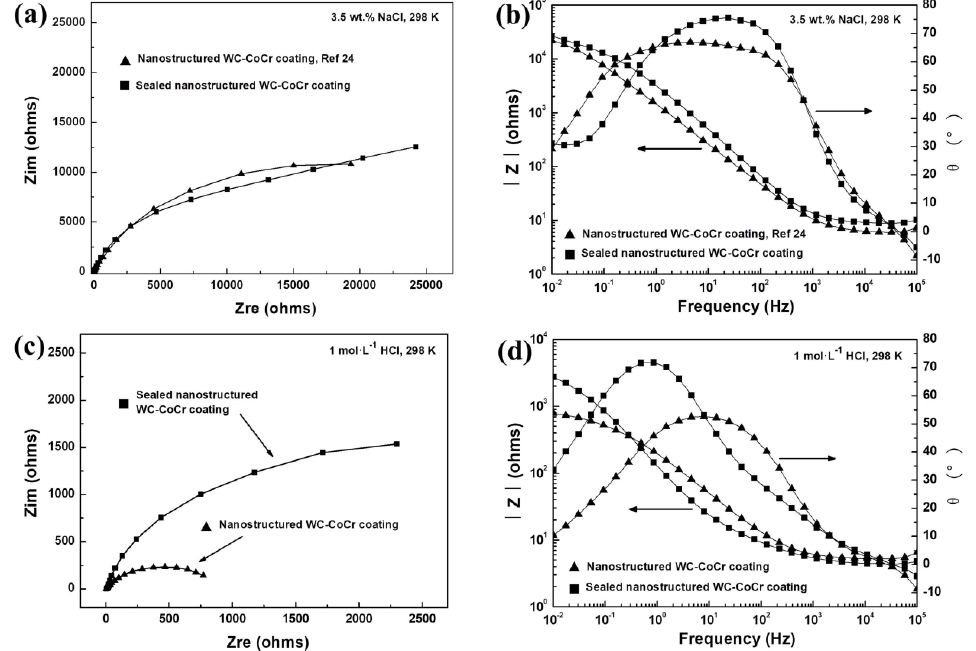
Figure 5. ( a , c ) Nyquist plots and ( b , d ) Bode plots of unsealed and sealed nanostructured WC ‐ CoCr coatings in ( a , b ) 3.5 wt % NaCl and ( c , d ) 1 mol ∙ L − 1